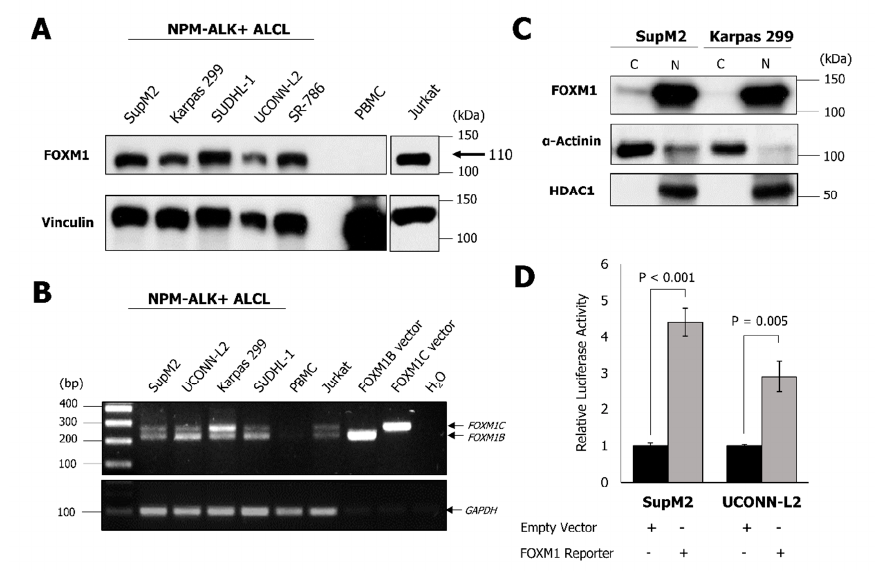
Figure 1. FOXM1 is expressed in NPM-ALK + ALCL cell lines. ( A ) Western blot analysis for FOXM1 expression in the indicated cell lines. ( B ) RT-PCR for transcript levels of FOXM1B and FOXM1C mRNA in the indicated cell lines. ( C ) Western blot analysis of cytoplasmic (C)/nuclear (N) fractions of two NPM-ALK+ ALCL cell lines. ( D ) Luciferase reporter assay with a FOXM1 reporter was used to assess FOXM1 transcriptional activity in the indicated cell lines. Data are representative of at least three biological replicates. PBMC; peripheral blood mononuclear cells.